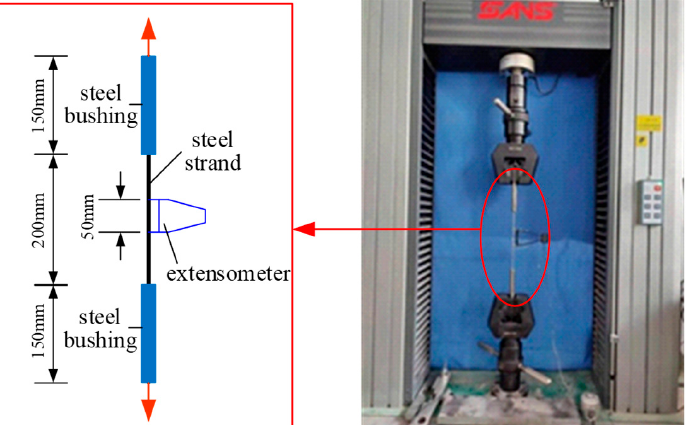
Table 3. Physical and mechanical indicators of PVA fiber.